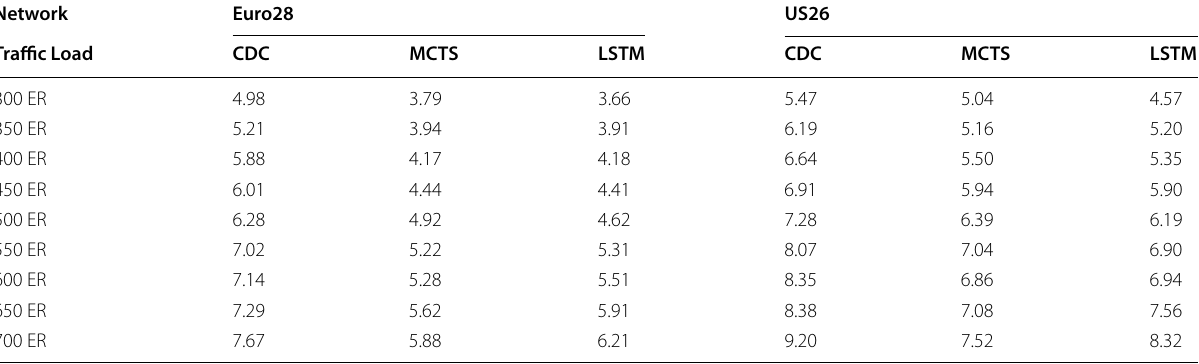
Table 2 Service cost per hour (in Usd), scenario #1